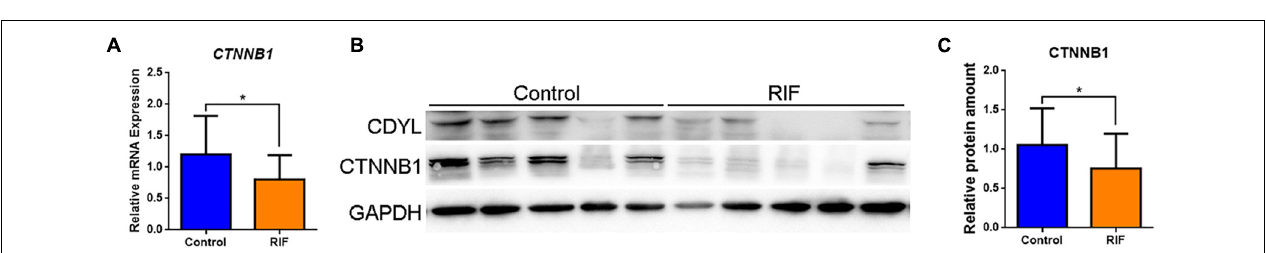
FIGURE 5 | The decreased expression of CTNNB1 after CDYL knockdown in Ishikawa cells, EECs, and ESCs. (A) DEGs involved in the endometrial receptivity and implantation were validated by RT-qPCR. Protein expression levels of CDYL and CTNNB1 were decreased after CDYL silencing in Ishikawa cells (B,C) , EECs (D,E) , and ESCs (F,G) shown by Western blot and densitometric quantification. N ≥ 3. All data are presented as mean ± SD. * P < 0.05; ** P < 0.01; *** P < 0.001.